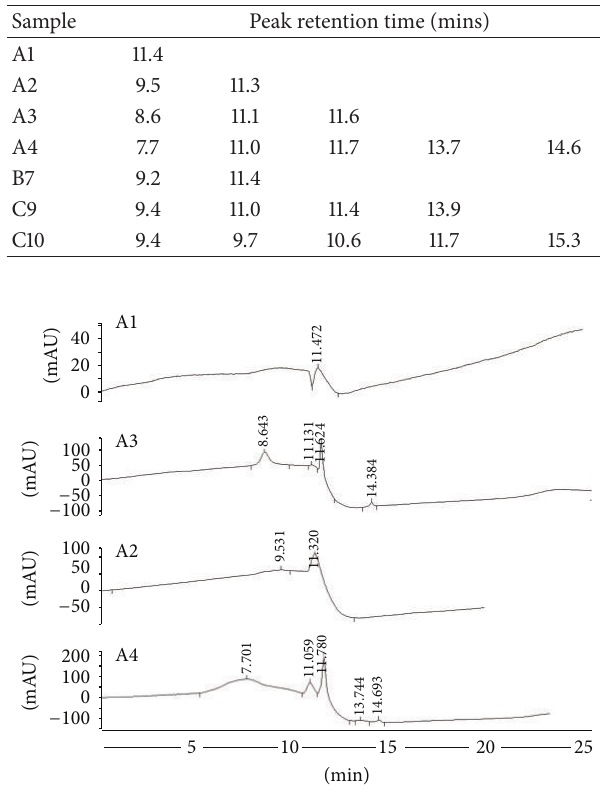
Figure 3: High and low molecular weight compounds of function- alized polyurethane foam samples based on BES/DMSO